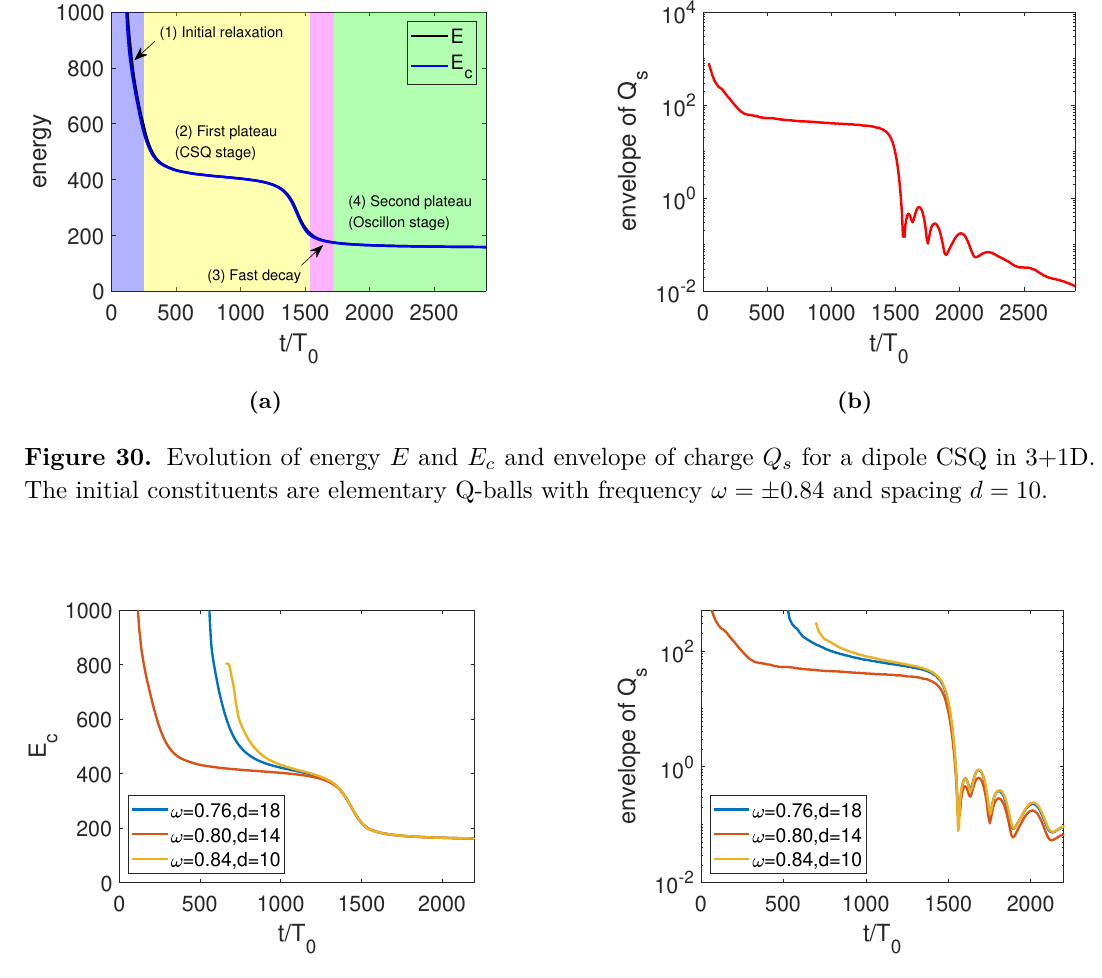
swapping period in 3+1D is about 1.5 times that in 2+1D for the dipole case. In figure